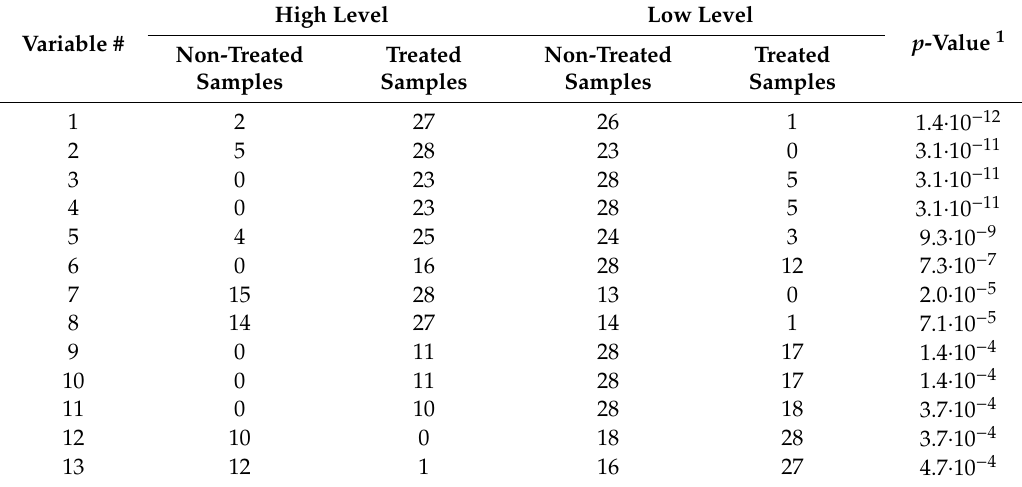
Figure 3. PCA representation of the treated and non-treated samples from the selected variables by SSIR. See text for more details. Table 3. Reckoning of high or low levels for dichotomic selected variables of the treated and non-treated samples.